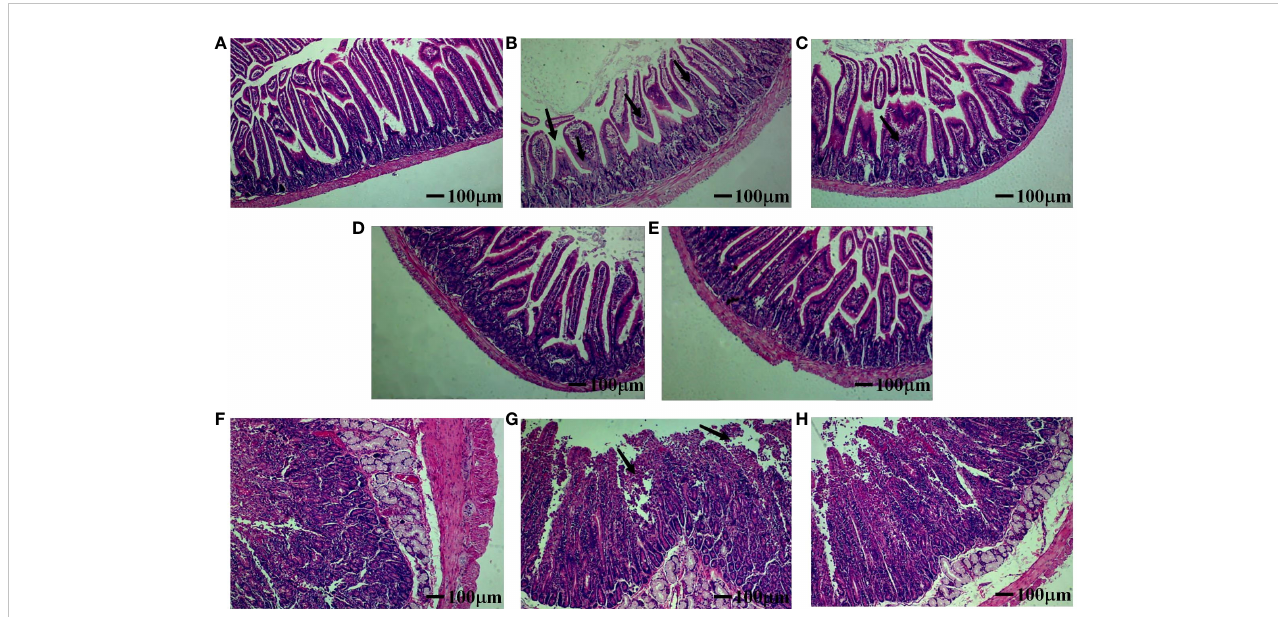
FIGURE 6 Effect of SeL or HiSeL on the pathological changes of jejunal tissue induced by the immunization of mice and rabbits after challenge. Jejunal tissue samples of mice and rabbits were gathered on day 28 after immunization to detect pathological changes. The pathological changes were examined by HE staining (magni fi cation of ×40), the black arrows point at the lesion location. (A) Control group of mice. (B) Vaccine group of mice. (C) L + Vac group of mice. (D) SeL + Vac group of mice. (E) HiSeL + Vac group of mice. (F) Control group of rabbits. (G) Vaccine group of rabbits. (H) SeL + Vac group of